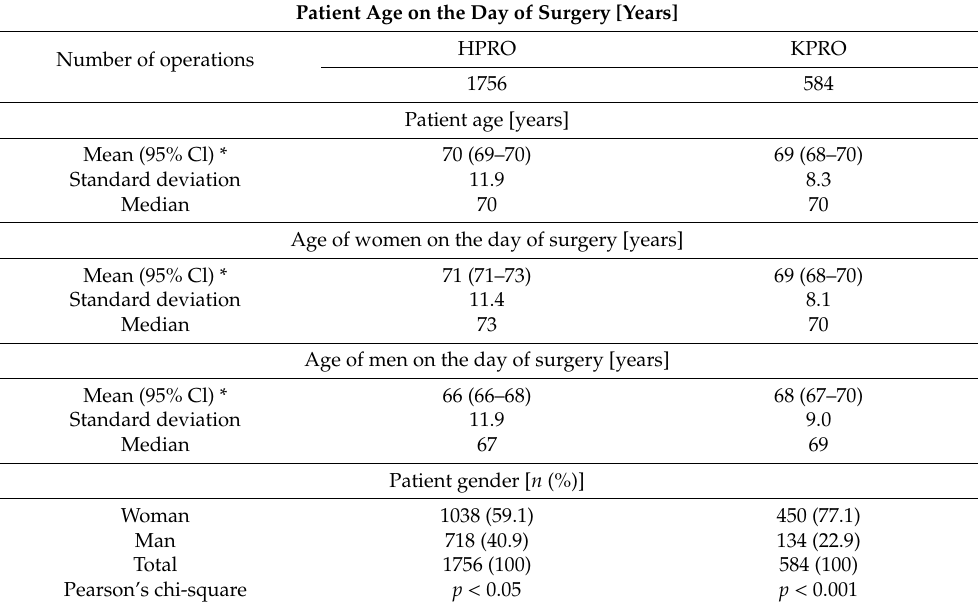
Table 2. Patient age on the day of surgery, considering the type of operation, gender and median in